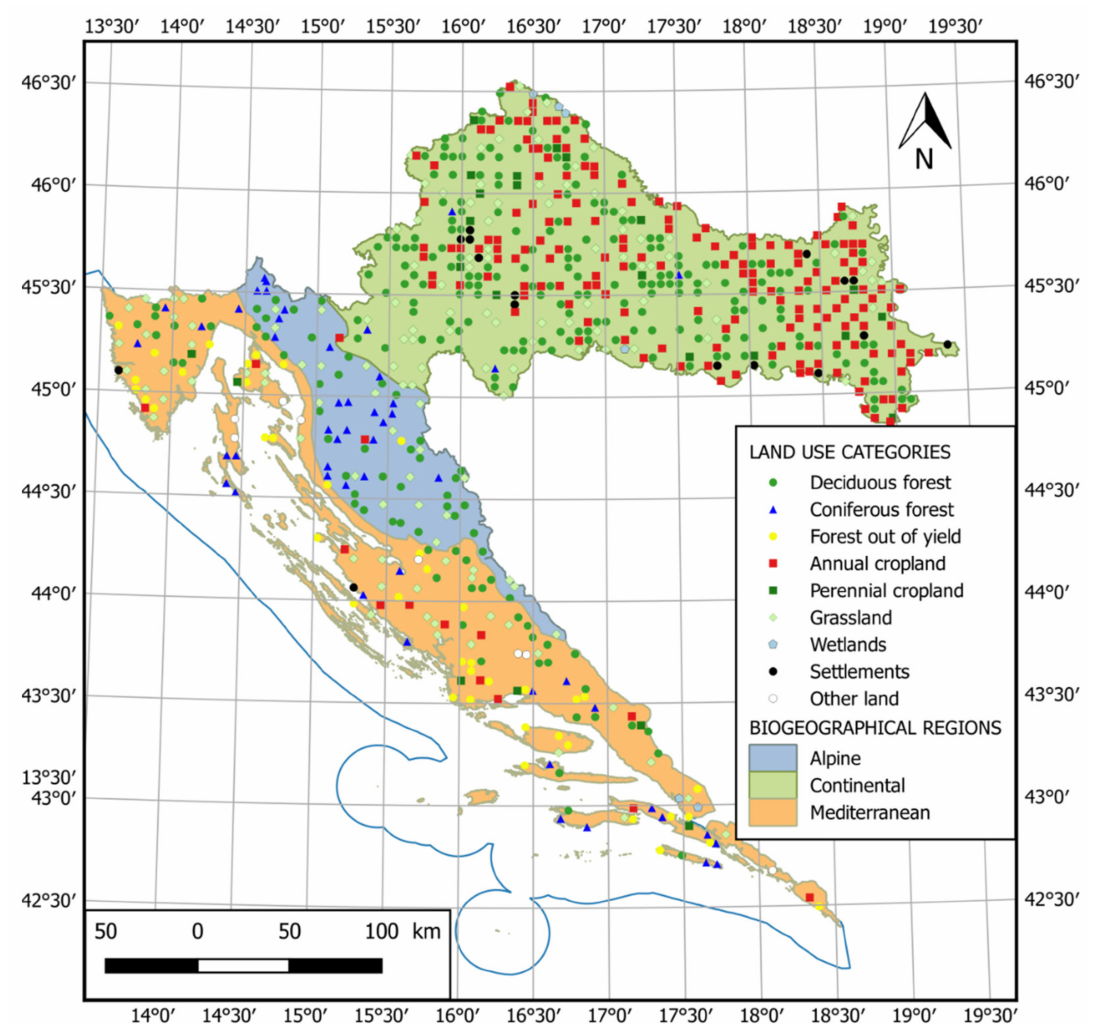
Figure 1. Biogeographical regions according to the European Environmental Agency [51] and national soil survey field plots distributed between land-use categories in Croatia in 2016 according to HR NIR 2020